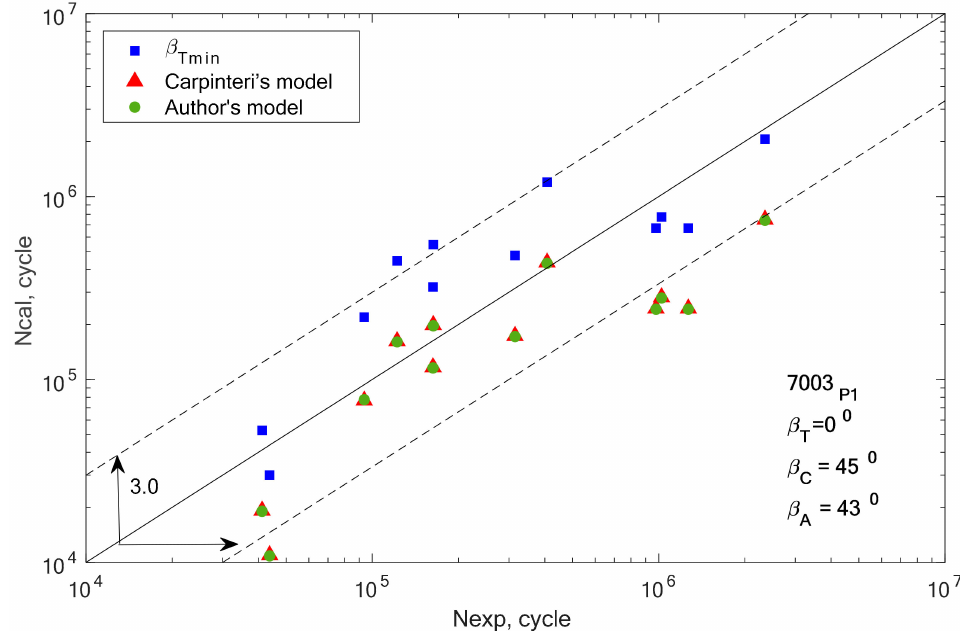
Figure 10. Comparison of the obtained design and experimental fatigue life for aluminium alloy 7003-P1 for the cyclic bending–torsion combination.